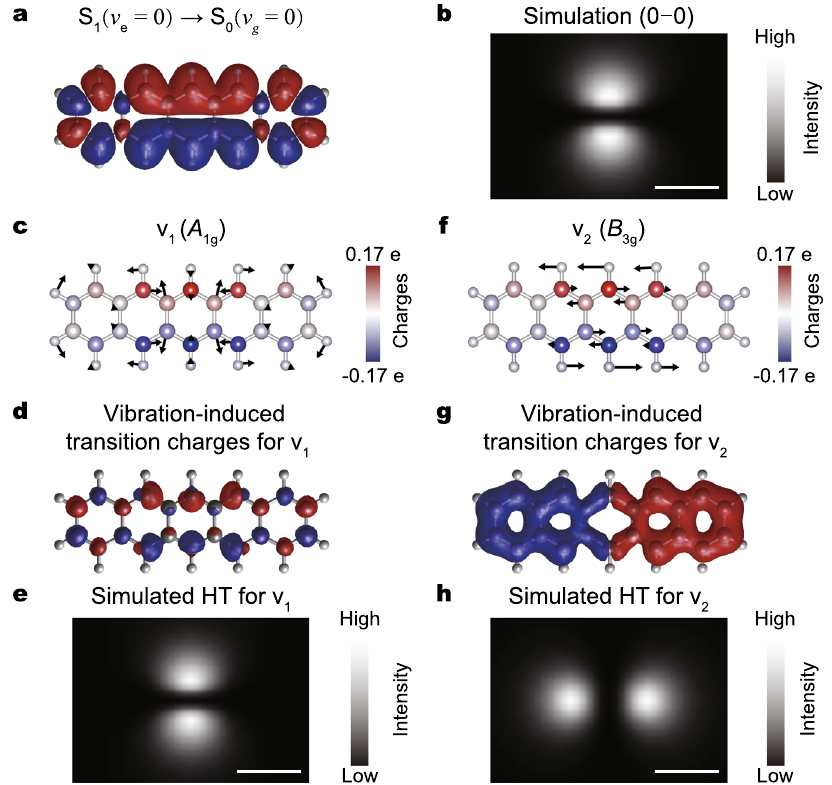
Fig. 3 Simulations on transition densities and vibration-induced transition charges. a Simulated transition densities for the S 1 → S 0 transition. The blue and red colors indicate the spatial distributions of the positive and negative charges. b Simulated photon image for the 0 – 0 transition. c , f Schematics of the vibrations for the v 1 and v 2 modes, superimposed with the S 1 → S 0 transition densities distributed over each atom by Hirsch fi eld population analysis. d , g Calculated vibration-induced transition charges for the v 1 and v 2 modes. e , h Simulated photon images of the HT-term contributions for the v 1 and v 2 modes. Scale bars, 1